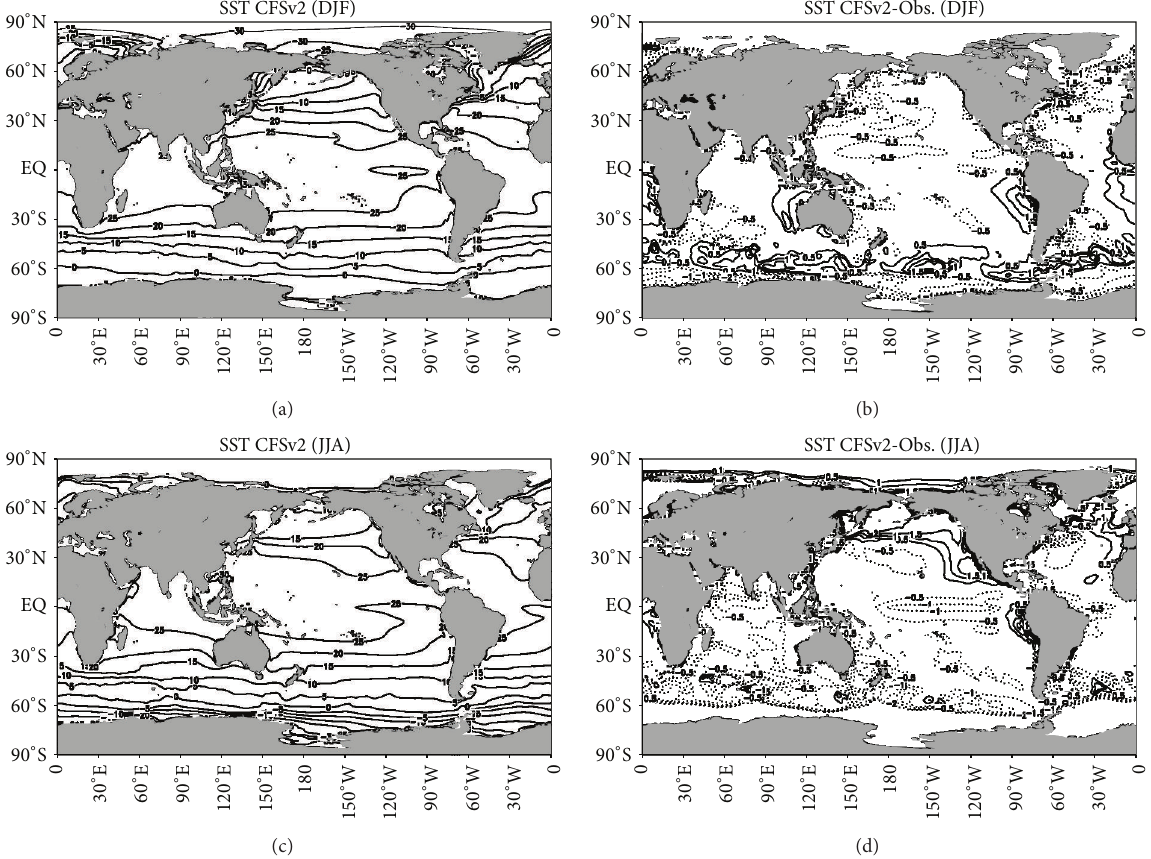
Figure 4: Sea surface temperature (SST) from the CFSv2 ((a) and (c)) and differences from observation ((b) and (d)) during DJF ((a) and (b)) and JJA ((c) and (d)) at 0-month lead. The climatology period is 1983–2010. Contour interval is 5 ∘ C in (a) and (c) and 0.5 ∘ C in (b) and